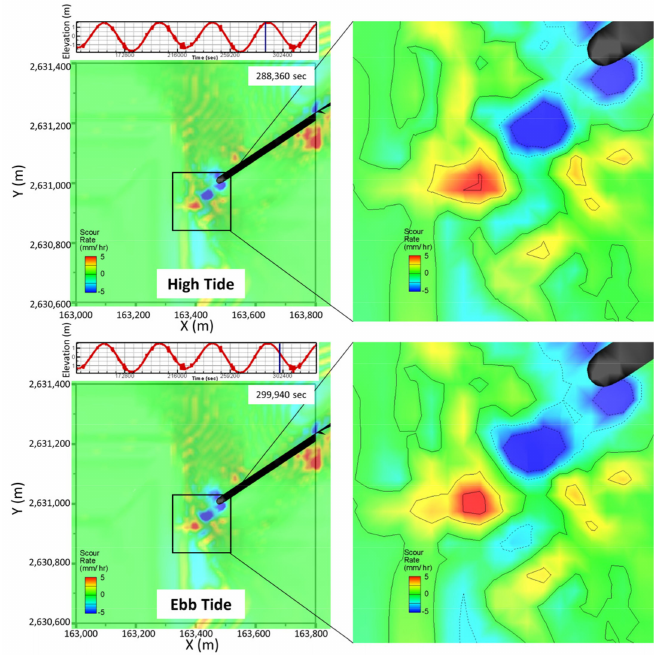
Figure 41. Topographic changes at high and ebb tide